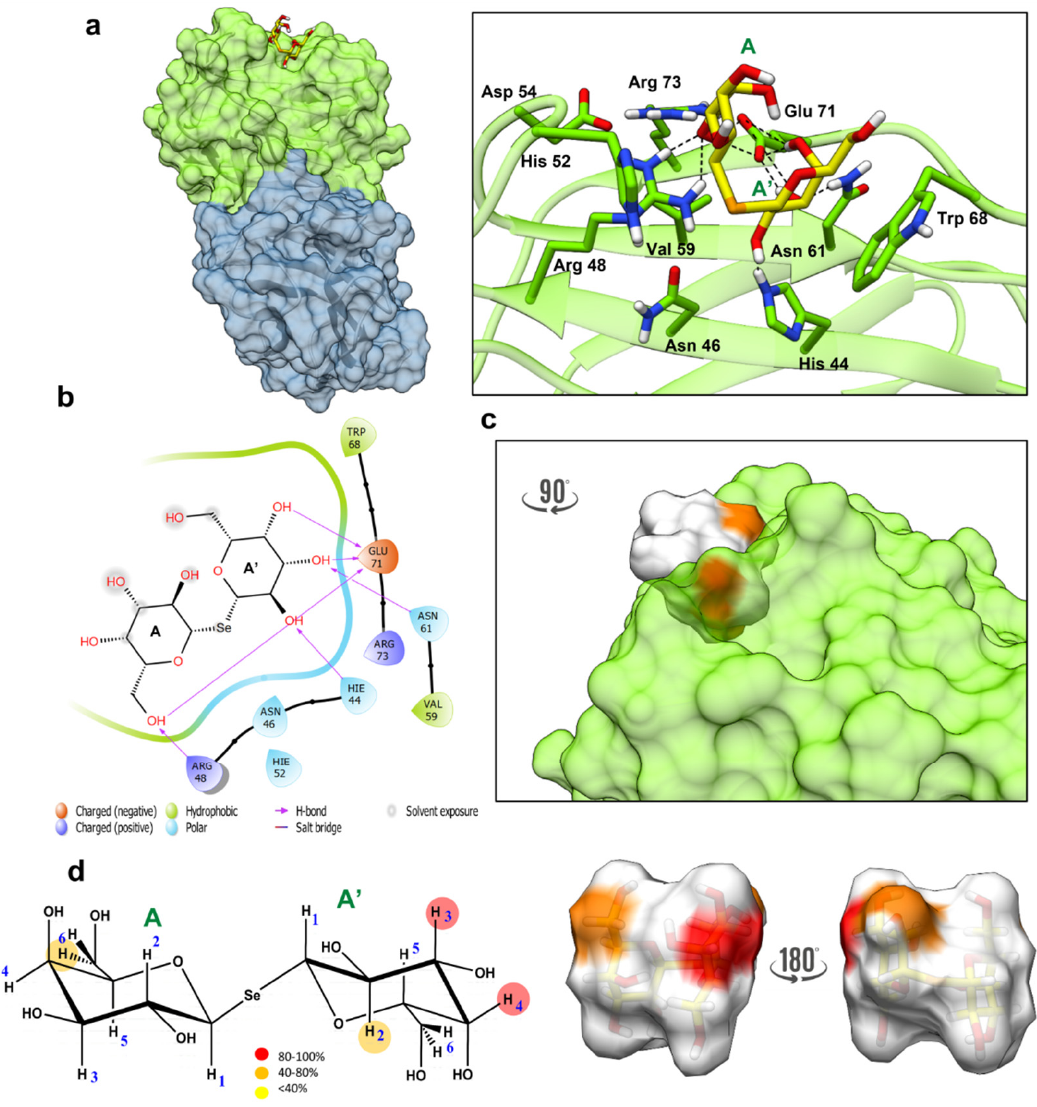
Figure 7. Interaction model between Gal-1 and SeDG). ( a ) The 3D model derived by docking and MD calculations of the Gal-1—SeDG system. A representative pose of the most populated MD cluster was considered to depict the interaction highlighting the main residues involved in the binding. ( b ) The 2D plot of the interactions between the SeDG and Gal-1 binding pocket residues. ( c ) Gal-1/SeDG 3D complex as derived by the combination of the MD and STD-NMR results. The ligand surface is colored according to the STD enhancements. ( d ) Interaction epitope mapping of SeDG derived from STD-NMR data on the left and a 3D representation of SeDG glycoside in the bioactive conformation, with the molecular surface colored according to the STD enhancements.